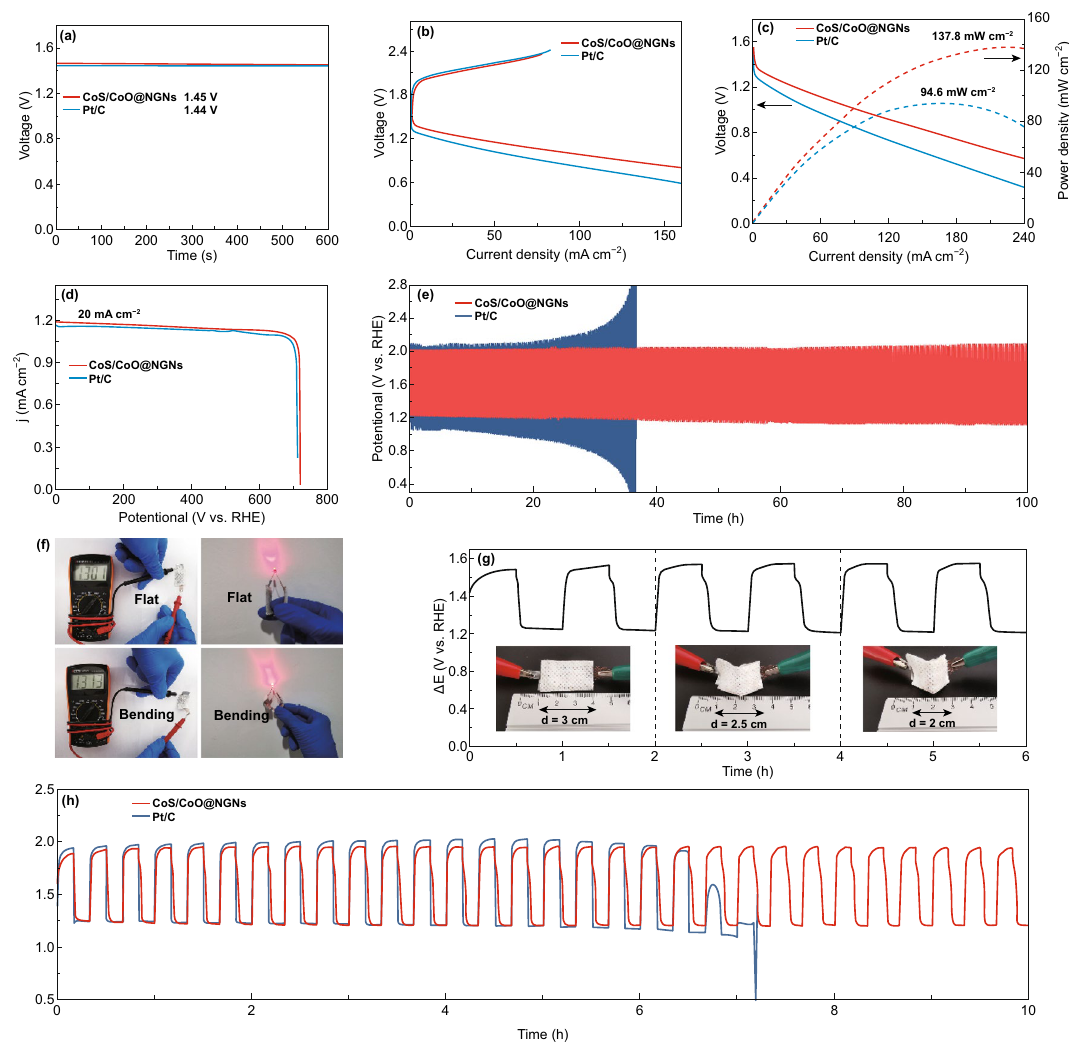
Fig. 5 a Open-circuit plots of assembled aqueous ZABs. b Discharge and charge polarization curves of aqueous ZABs. c Corresponding power density plots of aqueous ZABs. d Specific capacities of aqueous ZABs at 20 mA cm −2 . e Long-term discharge–charge cycling performances at 10 mA cm −2 . f Photograph of the open-current voltage for the single flexible quasi-solid-state ZAB, and a red LED powered by two batteries connected in series under flat and bending conditions. g Discharge–charge cycling curve of the flexible quasi-solid-state ZAB with CoS/CoO@ NGNs air electrode under different bending conditions. h Discharge–charge cycling curves of flexible quasi-solid-state ZABs at 1 mA cm